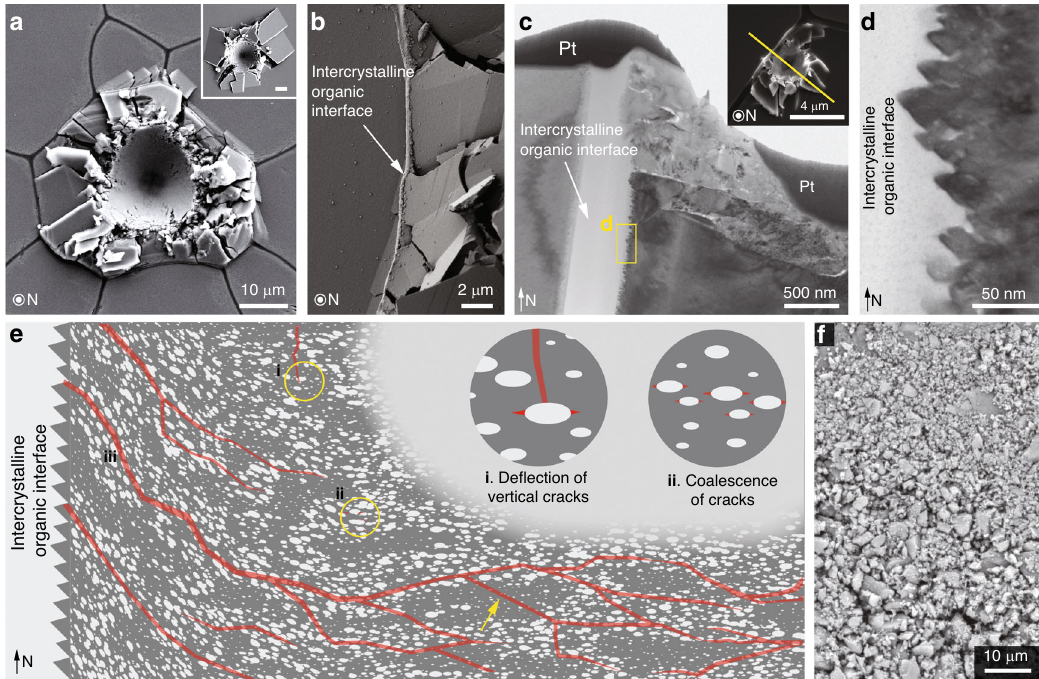
Fig. 7 Synergistic toughening mechanisms across multiple length scales. a Plan view SEM image of a high-load indentation on A. rigida biogenic calcite (conospherical tip; tip radius = 5 μ m; semi-angle = 45°; maximum load = 500 mN). Inset: Plan view SEM image of geological calcite under the same loading condition; scale bar 10 μ m. b Damage localization by the intercrystalline organic interfaces as the micro-fracturing in the prism on the right was completely stopped by the interface. c Cross-sectional TEM image showing that the inelastic deformation was effectively localized by the organic interface beneath the sample surface. Inset: Plan view SEM image of the original indentation residue. The yellow solid line indicates the location and orientation of the TEM sample prepared by FIB. Pt, protective platinum layer. d A characteristic saw-tooth-like microstructure observed on the vertical surface of the prisms. e Schematic illustrating the regulation of crack formation and propagation (indicated by red lines) in the A. rigida biogenic calcite due to the intracrystalline defects, including (i) crack de fl ection; (ii) crack initiation resulting from micro-crack coalescence in regions with high defect density; and (iii) extensive upwardly directed cracks due to the inclined defects near prism boundaries. The yellow arrow shows that regions with a low density of defects fracture similar to pure calcite. f Micro-/nano-scale fractured pieces of the A. rigida biogenic calcite after extensive